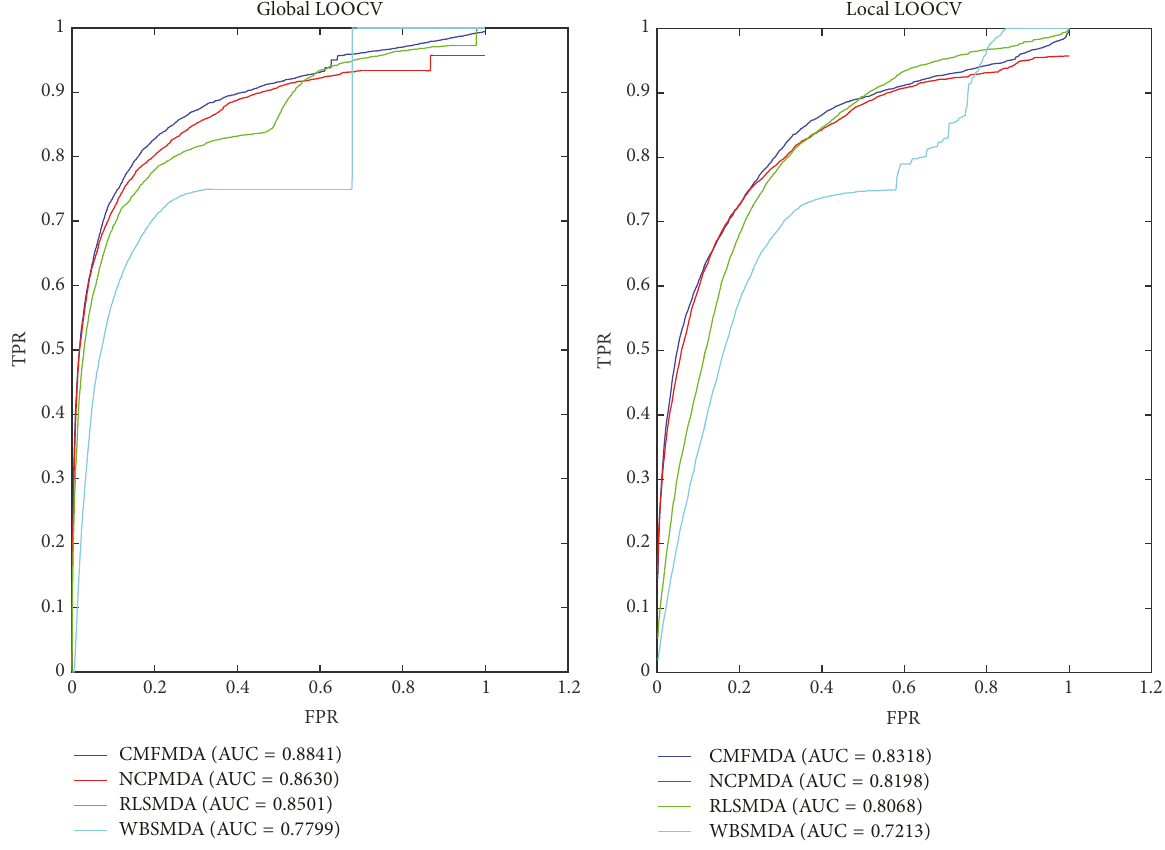
Figure 2: Performance comparisons between CMFMDA and three state-of-the-art disease-miRNA association prediction models (NCPMDA, RLSMDA, and WBSMDA) in terms of ROC curve and AUC based on local and global LOOCV, respectively. As a result, CMFMDA achieved AUCs of 0.8841 and 0.8318 in the global and local LOOCV, significantly outperforming all the previous classical models.